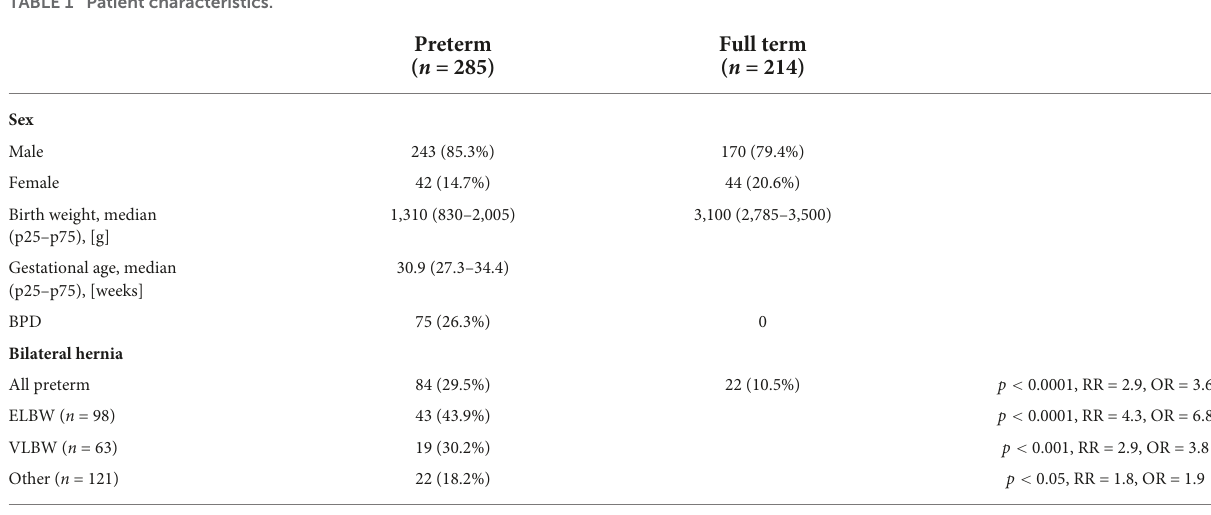
TABLE 1 Patient